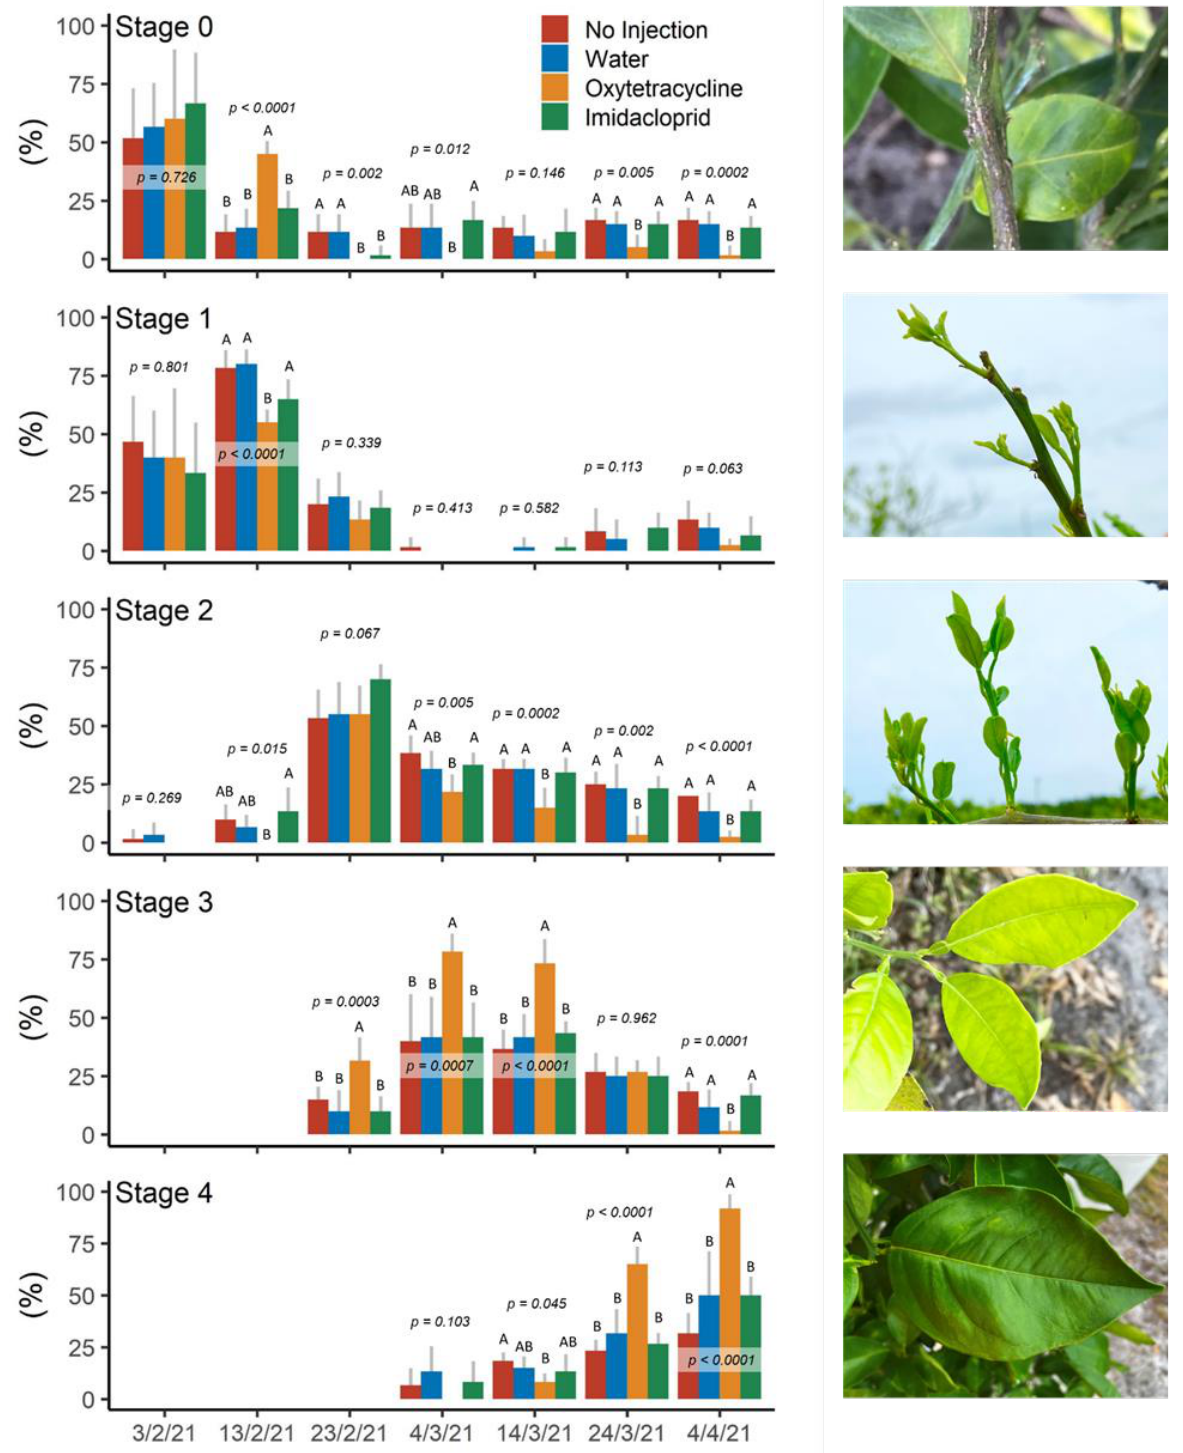
Figure 5. Emergence and maturation patterns of new flush in spring 2021 after injection in October 2020. S0 = no flush; S1 = feather stage; S2 = elongation stage; S3 = expansion stage; S4 = hardening stage. Different letters within each time point indicate significant differences ( p < 0.05) according to Tukey’s honest significant difference test. Letters not shown when differences were not signific ant.